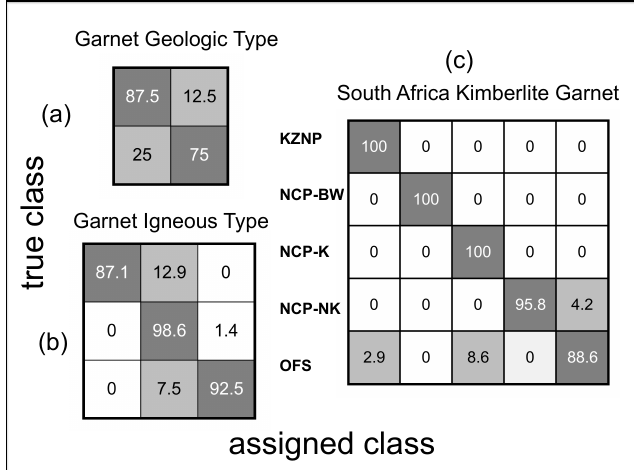
Figure 5. PLSDA classification matrices from handheld LIBS analysis of garnets by ( a ) geological type and ( b ) igneous host type, and ( c ) for garnets from five South African kimberlite locations (after Harmon et al. [79]): IGN = igneous, MET = metamorphic; CP = chromitite pods, GPR = granitic pegmatites and rhyolites, and K = kimberlites; KZNP = KwaZulu-Natal Province, NCP-BW = Barkley West, in Northern Cape Province, NCP-K = Kimberley in Northern Cape Province, NK = North of Kimberley in Northern Cape Province, and OFS = Orange Free State (data from Reference [79]). See text for